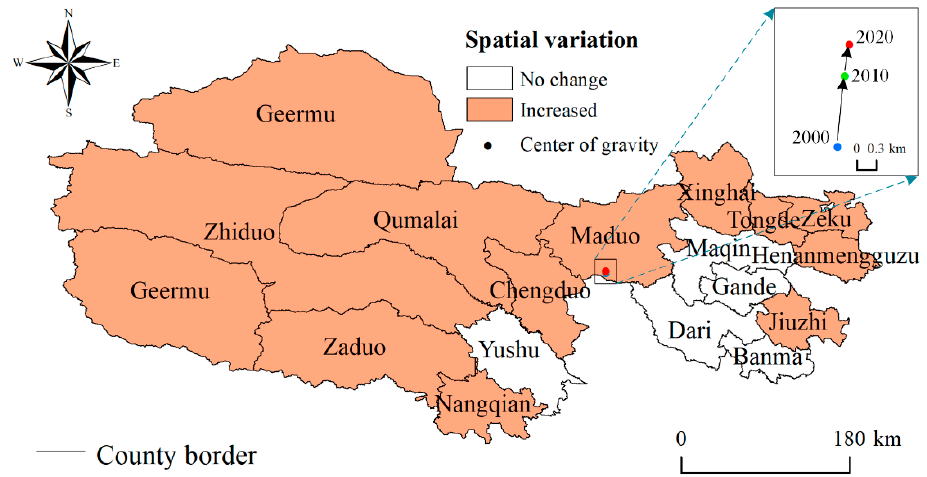
Figure 3. Spatial changes and shifts in the center of gravity of the human well-being index (HWI) in the Sanjiangyuan area during 2000–2020.